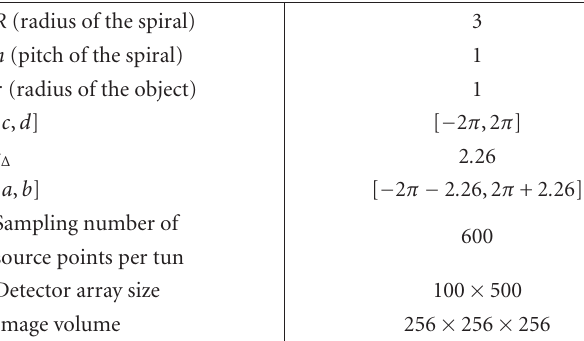
Table 2: Parameters of the data collection